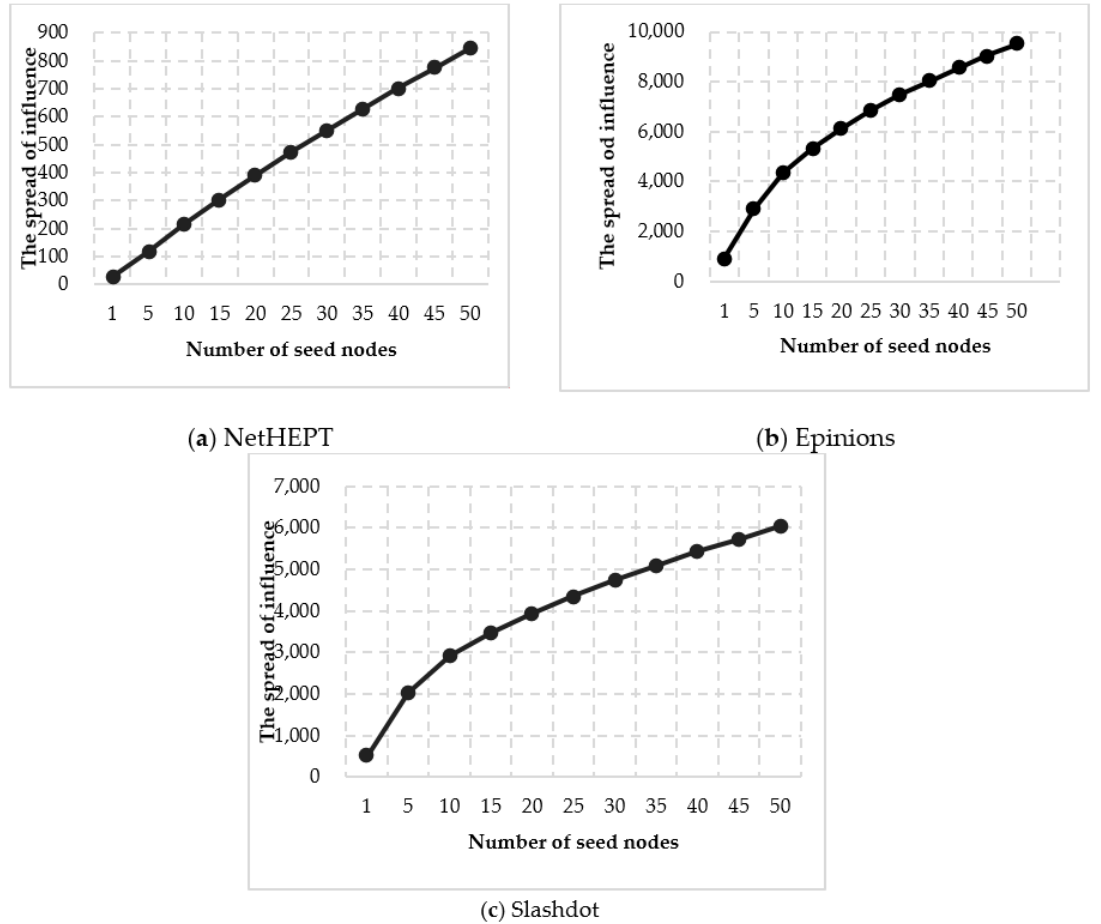
Figure 4. The spread of influence in a single social network. ( a ) The spread of influence in NetHEPT; ( b ) The spread of influence in Epinions; ( c ) The spread of influence in